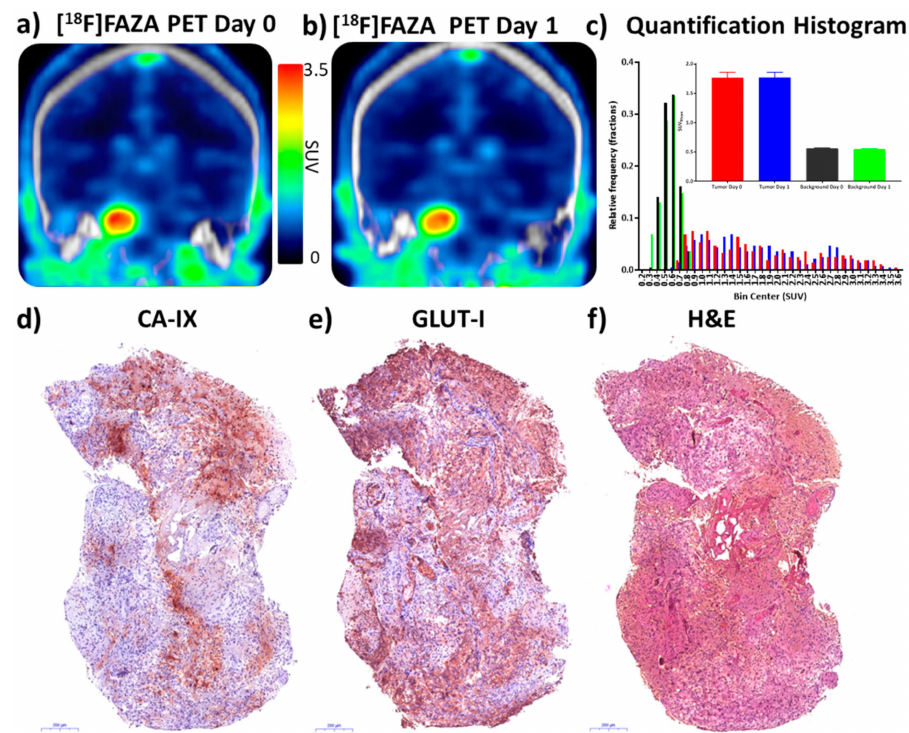
Figure 7. [ 18 F]FAZA retention in a patient with glioblastoma yields high contrast, reproducible PET / CT images of hypoxia confirmed by immunohistochemical analysis. A patient with a grade IV right pontine glioblastoma was enrolled in an ongoing test-retest clinical trial and injected with [ 18 F]FAZA (5.2 MBq / kg) on Day 0 and Day 1. PET / CT scans were acquired in LIST mode for analysis. ( a , b ) PET / CT images 2 h post injection were reconstructed and converted into SUV units (g / cc); representative coronal images through the peak of tumor retention are illustrated. ( c ) VOIs were drawn from PET images and background VOIs were created by mirroring tumor VOIs to contralateral brain. Individual pixel values were extracted from VOIs and histograms plotted of Day 0 and Day 1 pixel values for both tumor and background; (inset) SUV mean ± 95% CI. Key for c: Tumor Day 0 = red, tumor Day 1 = blue, background Day 0 = black, background Day 1 = green. ( d , e ) Post-op tumor specimens were stained for two independent markers of cellular hypoxia, CA-IX and GLUT-1. ( f ) H&E